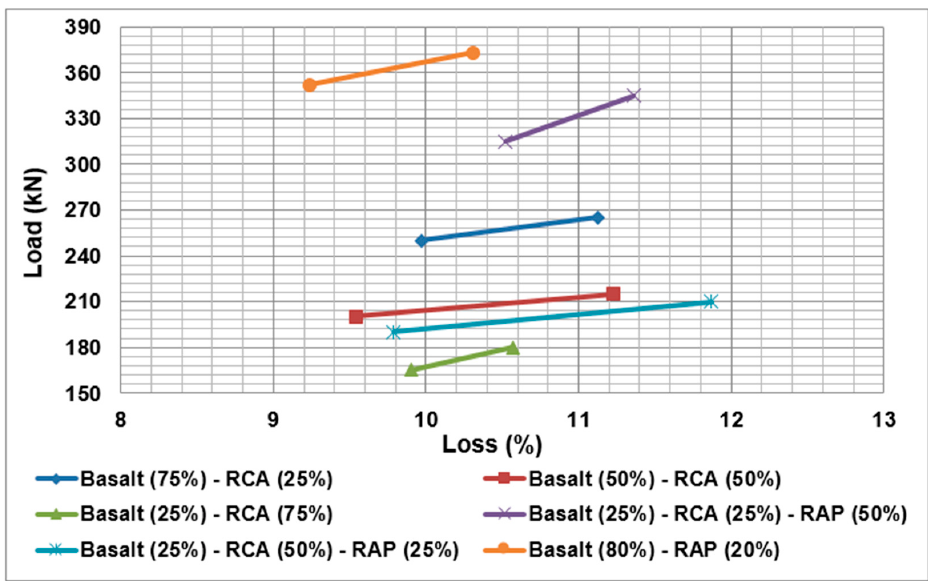
Figure 12. Results of Wet/Dry Strength Test for Mix of Coarse Aggregates (Wet Strength). Table 9. The Results of Wet/Dry Strength Variation Test for Different Mix of Coarse Aggregates.